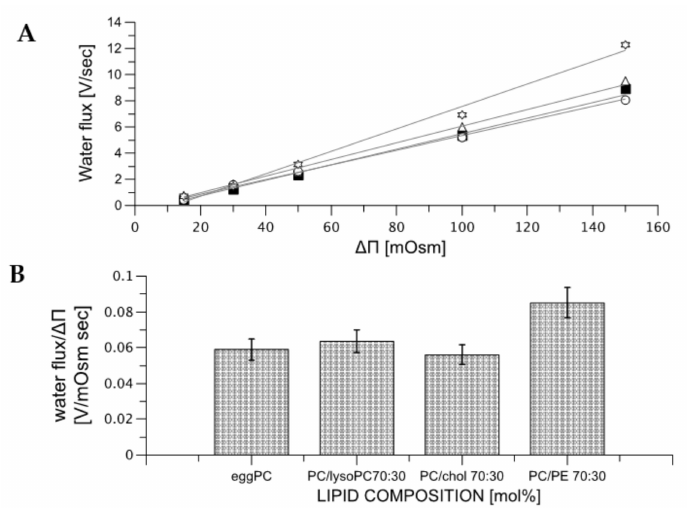
Figure 4. Panel ( A ) presents the water flux as a function of the osmotic pressure difference for membranes formed from different mixtures of lipids; ( )—egg-PC/cholesterol 70/30 mol%, (cid:35) ( (cid:52) )—egg-PC/lysoPC 85/15 mol%, ( (cid:53) )—egg-PC/lysoPC 70/30 mol% and ( (cid:79) ;)—egg-PC/PE 70/30 mol%. Panel ( B ) visualize the quantitative change of water flux (slopes for curves from panel ( A ) for selected membrane compositions).